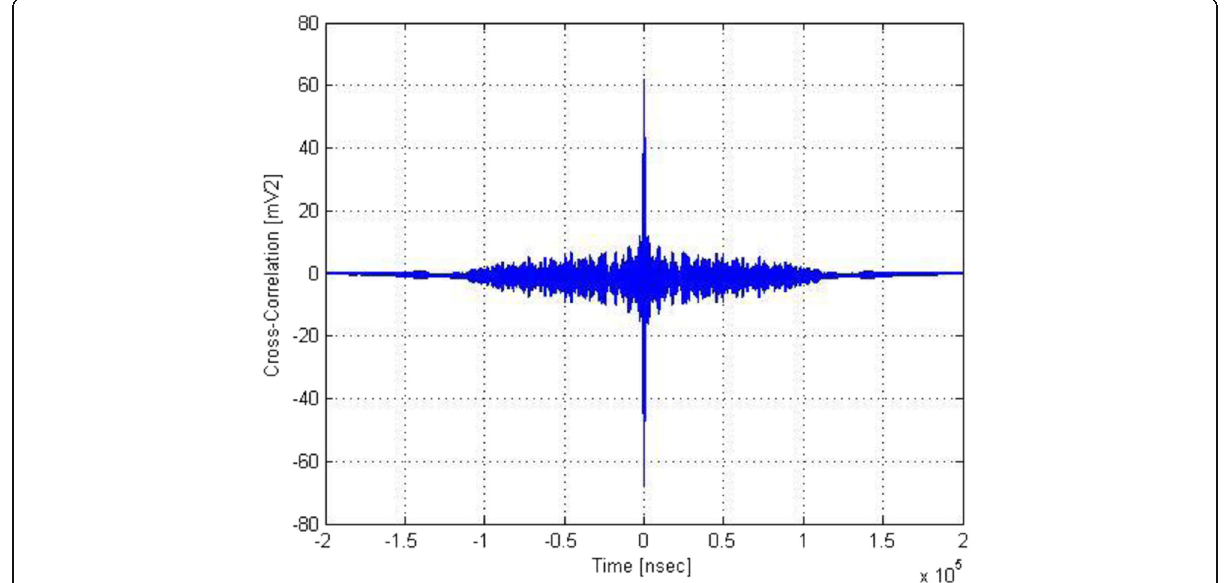
Fig. 6 Correlation pick as a result of